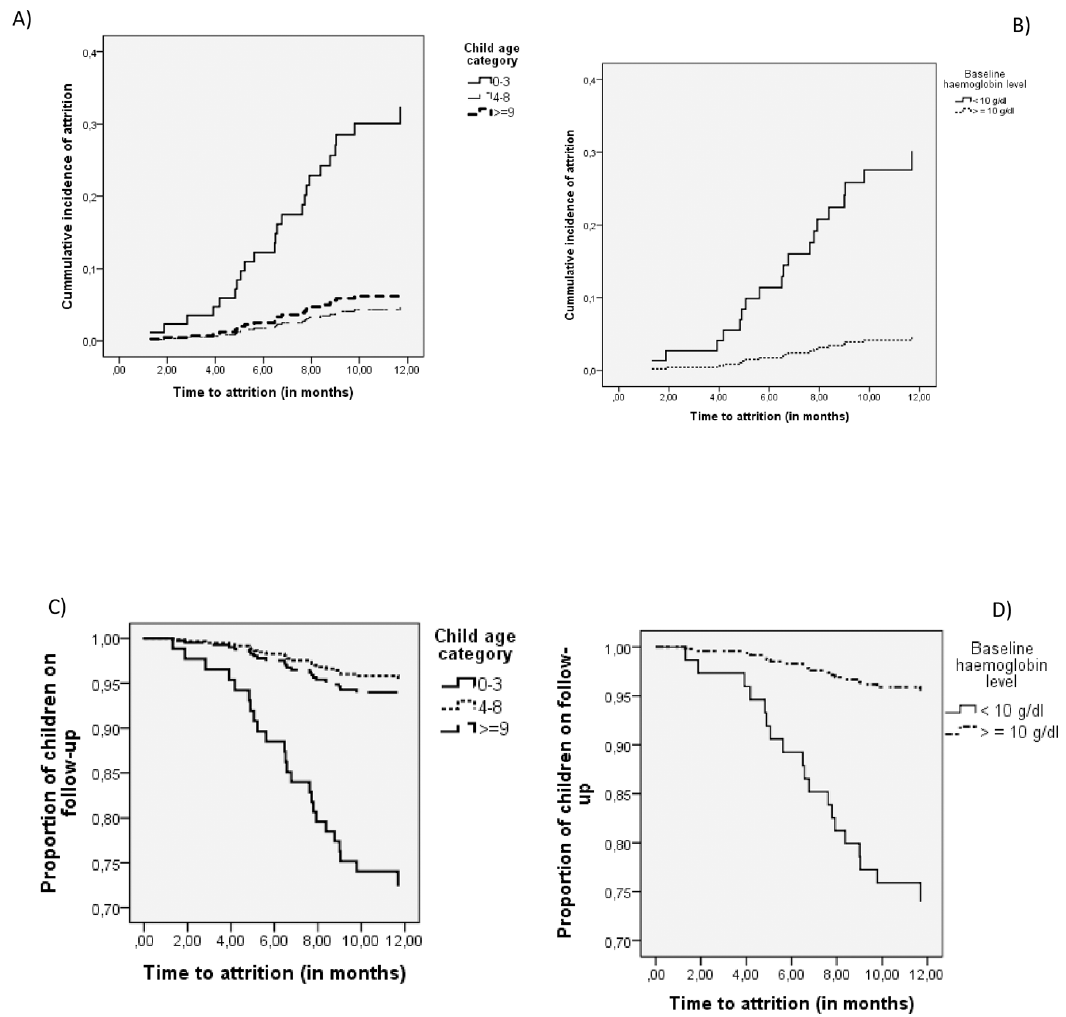
Fig 2. Cumulative incidence and survival curve of recorded attrition. A) Cumulative incidence by child age group, B) Cumulative incidence by child baseline Hgb, C) Survival curve by child age group and D) Survival curve by child baseline